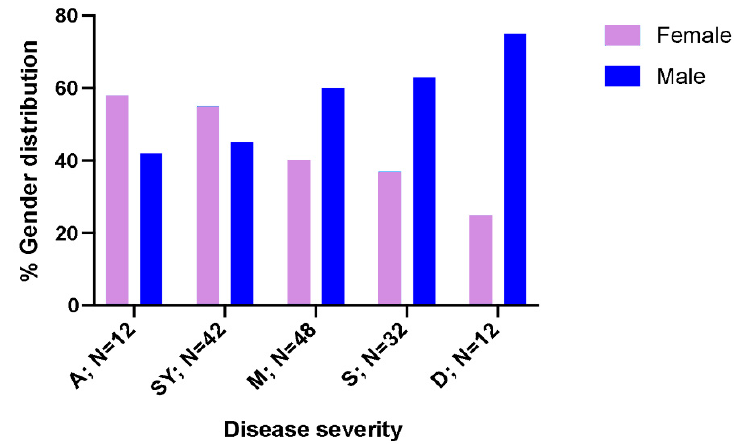
Figure 2. Sex distribution according to disease progression. A: asymptomatic; SY: symptomatic without hospitalization requirements; M: mild to moderate; S: severe; D: deceased patients. p -value = 0.021. Light purple: Female; Dark blue: Male.